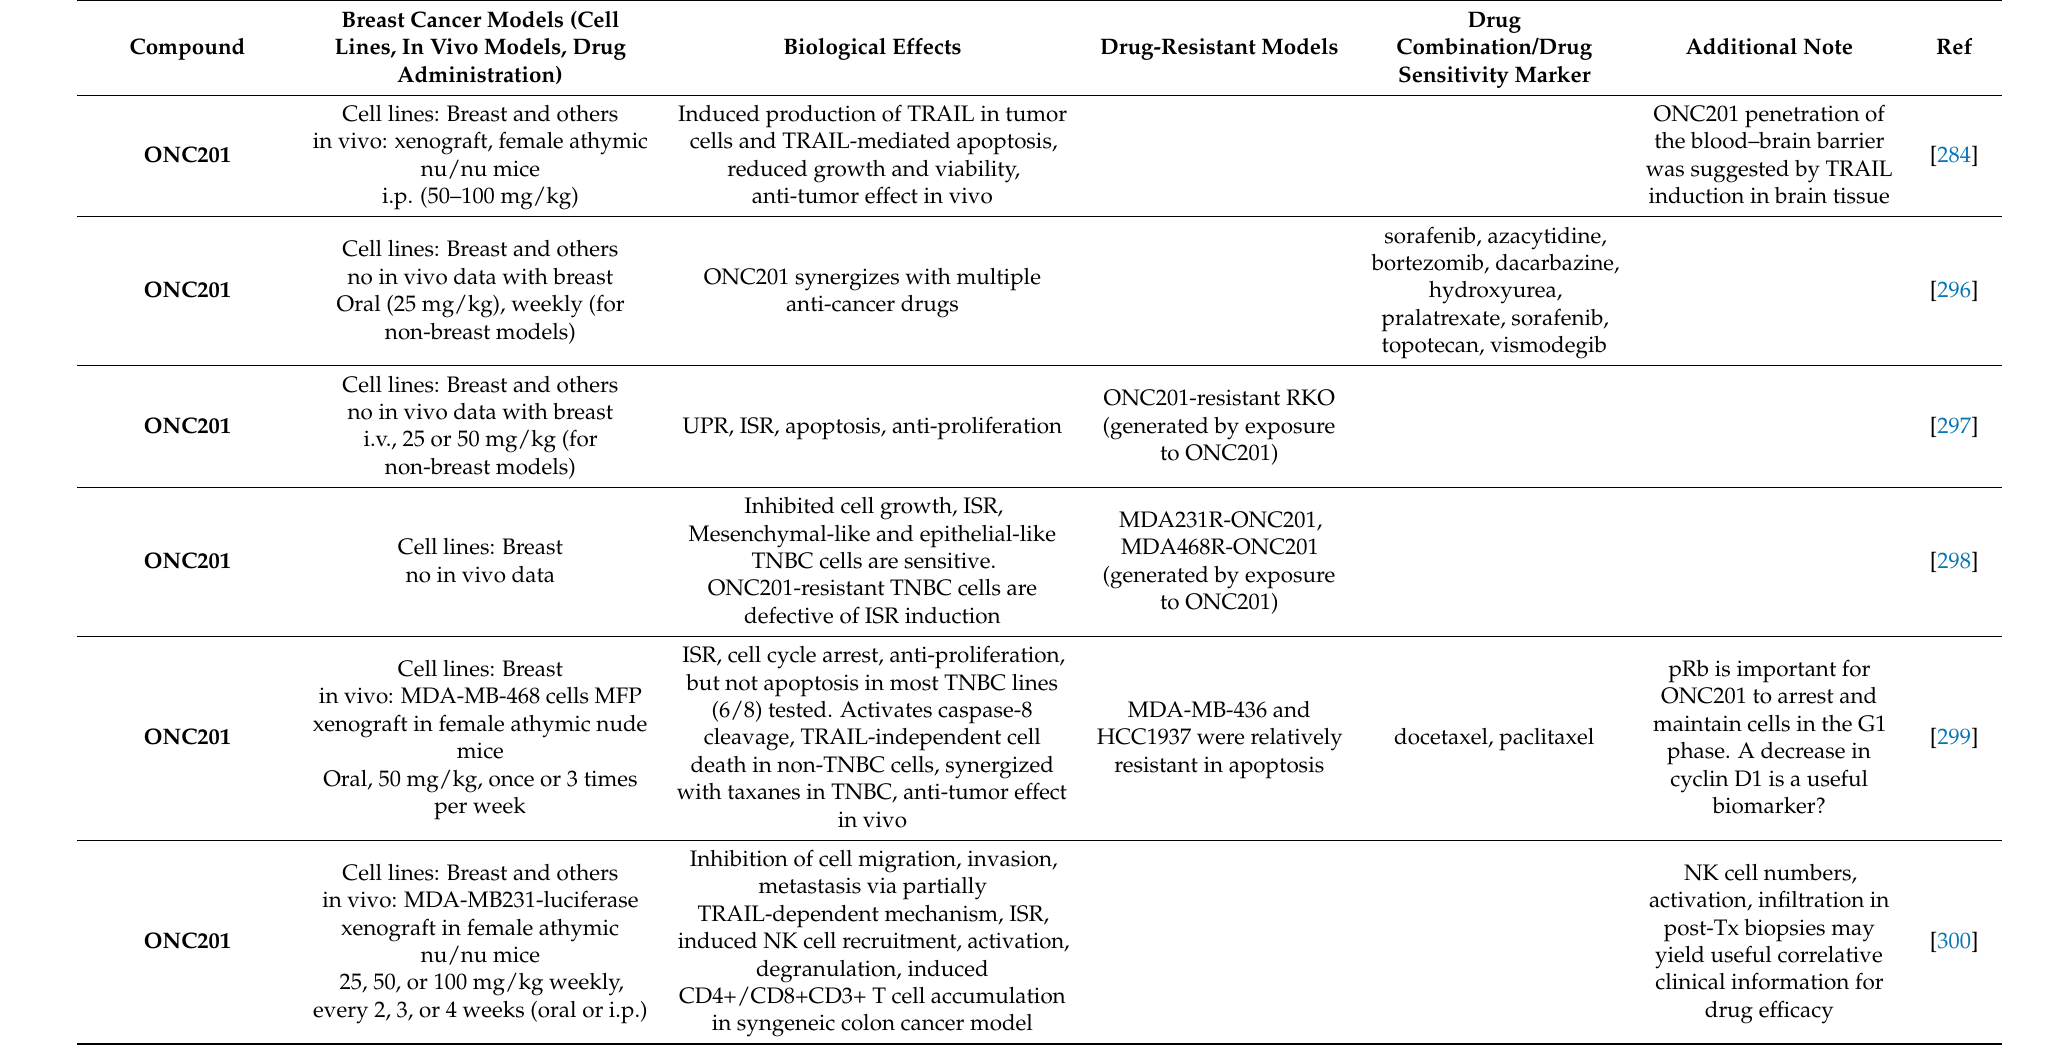
Table 1. Preclinical studies using ClpP agonists in breast